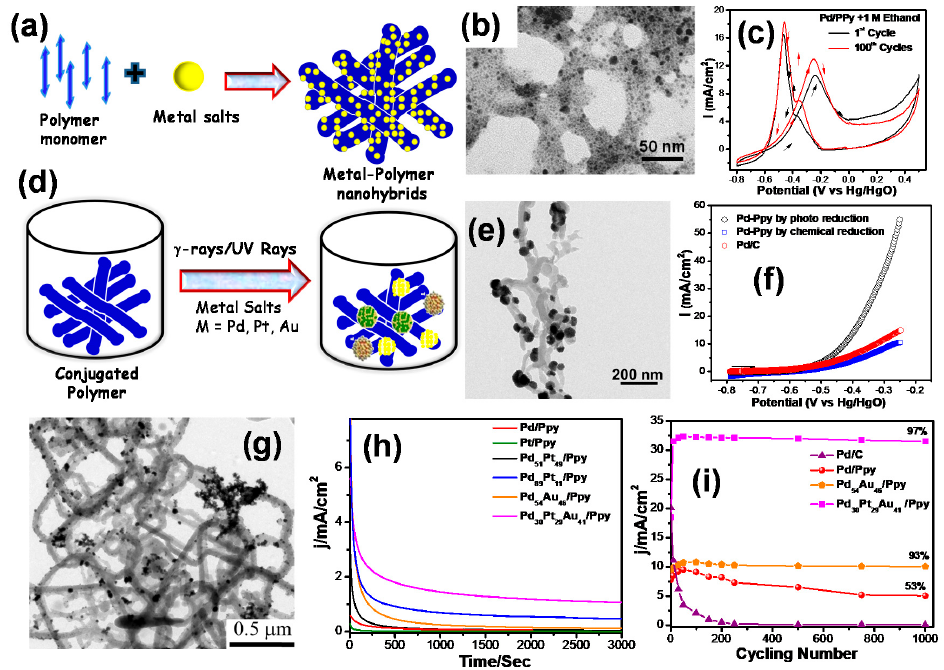
Figure 3. ( a ) Schematic representation of in situ metal–polymer nanohybrids; ( b ) transmission electron micrograph of Pd / PPy NHs;( c ) cyclic voltammograms of Pd / PPy NHs and superposition of the first (black solid line curve) and the 100th (red solid line curve) scans for the electrocatalytic oxidation of 1 M EtOH in 1 KOH; ( d ) formation of metal nanoparticles on conducting polymer nanofibers by radiolysis or UV radiation; ( e ) transmission electron micrograph of the Pd / PPynanohybrid; ( f ) the forward scan peaks of the cyclic voltammetry (CV) of Pd / PPy via photoreduction, of Pd / PPyvia chemical reduction, and of Pd / C for the electrocatalytic oxidation of 1 M EtOH [49]; ( g ) typical TEM images of Pd 30 Pt 29 Au 41 / PPy nanohybrids; ( h ) chronoamperometric curves for ethanol oxidation at constant potential − 0.25 V vs. Hg / HgO on Pd / PPy, Pt / PPy, Pd 89 Pt 11 / PPy, Pt 49 Pd 51 / PPy, Pd 54 Au 46 / PPy, and Pd 30 Pt 29 Au 41 / PPy electrodes; and ( i ) long cycling study of Pd / C, Pd / PPy, Pd 54 Au 46 / PPy, and Pd 30 Pt 29 Au 41 / PPy electrodes in a solution of 1M KOH and 1M ethanol at a scan rate of 50 mV s − 1 [50]. Additionally, multilayered PtPd / PPy / PtPd [51] and Pd / PANI / Pd [52] were also developed